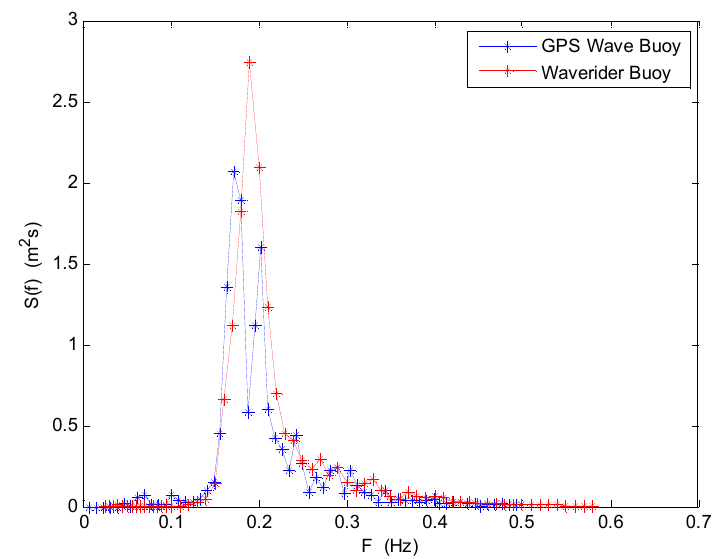
Figure 4. Comparison of wave frequency spectrum between the SBF7-1A GPS wave buoy and the DWR-MKIII Waverider buoy before correction at 03:00 (UTC) on 2 July 2013.